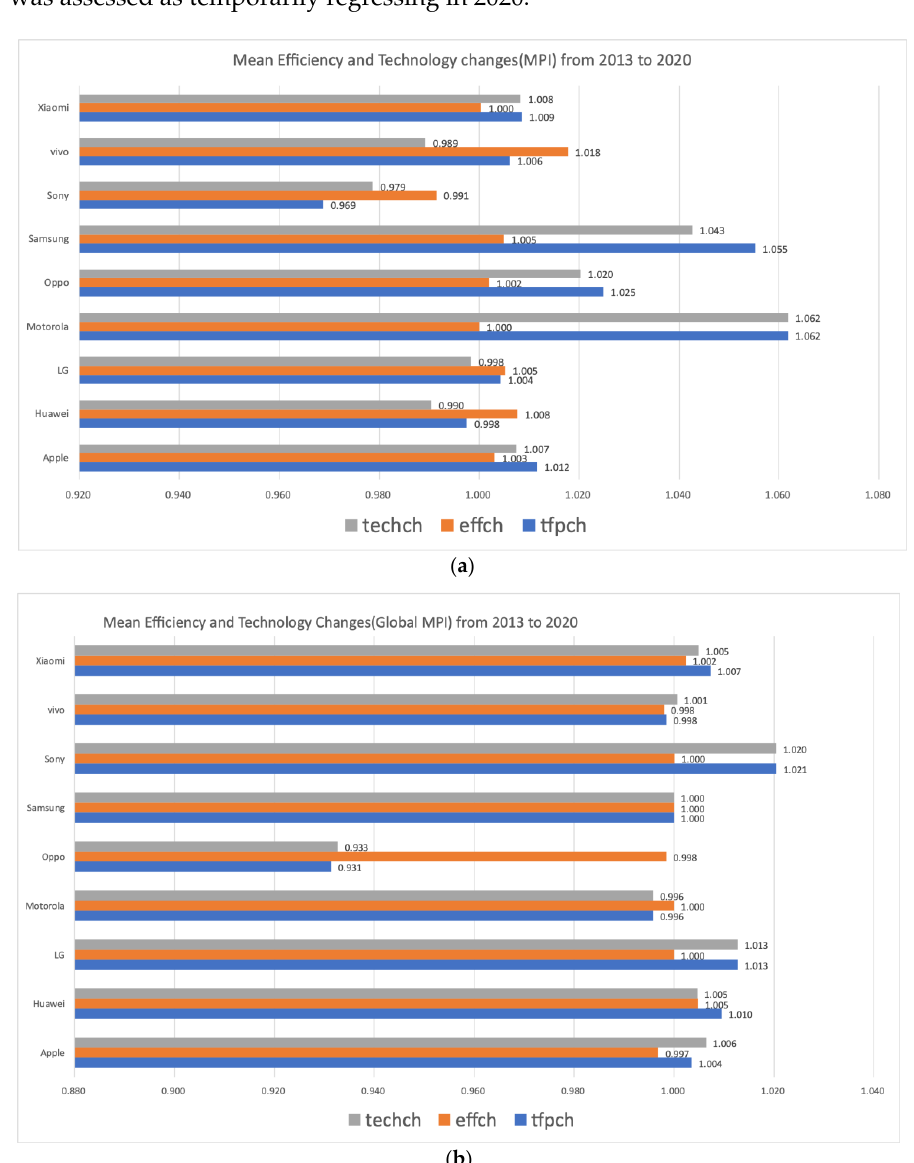
Figure 2. Mean efficiency and technology changes for the period of 2013–2020: ( a ) MPI; ( b ) Global Figure MPI.